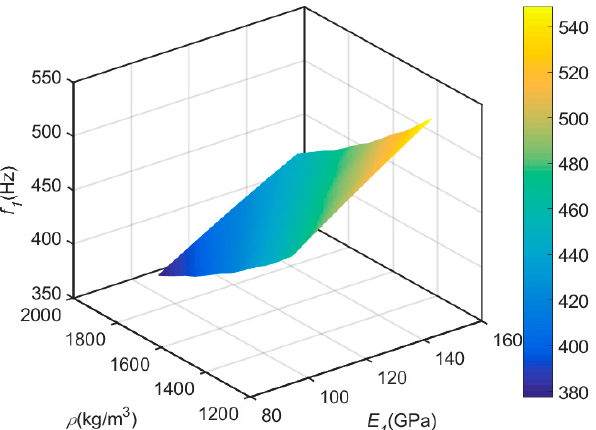
Figure 8. The influencing curved surface of density ( ρ ) and elasticity modulus ( E 1 ) along the fiber direction on first-order inherent frequency ( f 1 ) .